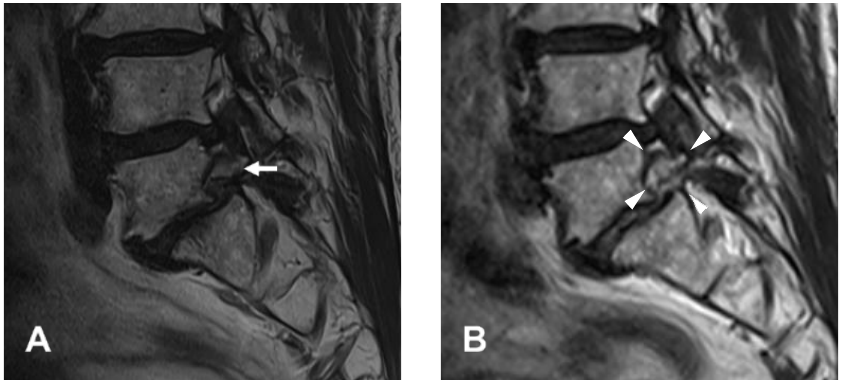
Figure 3. An illustrative case of a 65-year-old male patient. ( A ) Preoperative magnetic resonance image (MRI) showing foraminal stenosis with spondylolisthesis at the L5-S1 level (arrow). ( B ) Postoperative MRI showing foraminal decompression after resection of the bone and soft tissues (arrowheads).